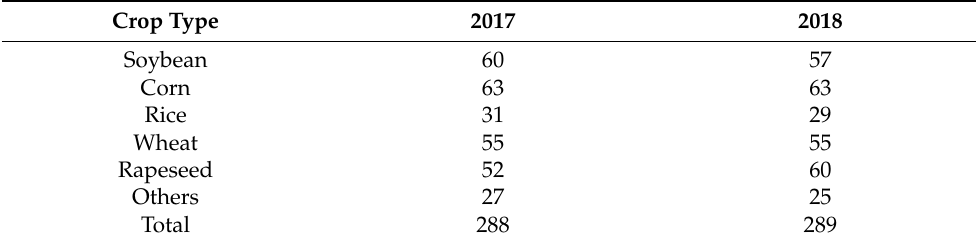
Table 3. The number of selected regions of interest (ROI) in 2017 and 2018.